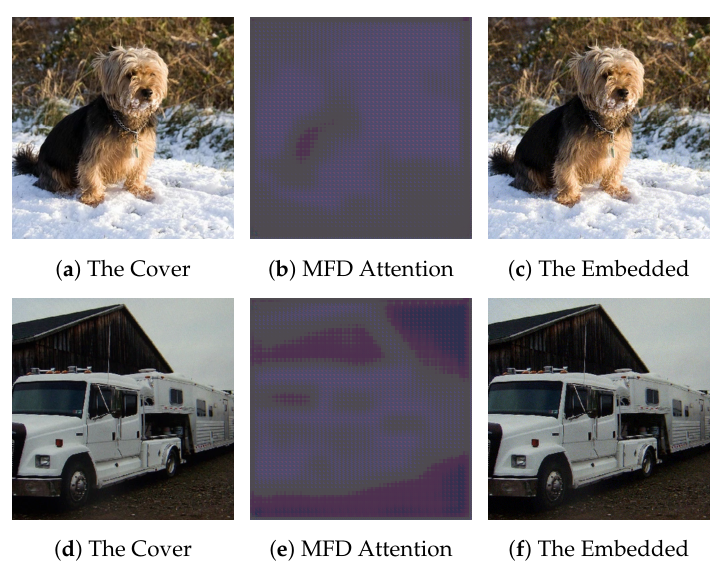
Figure 12. The visual effect of MFD attention on embedding with random